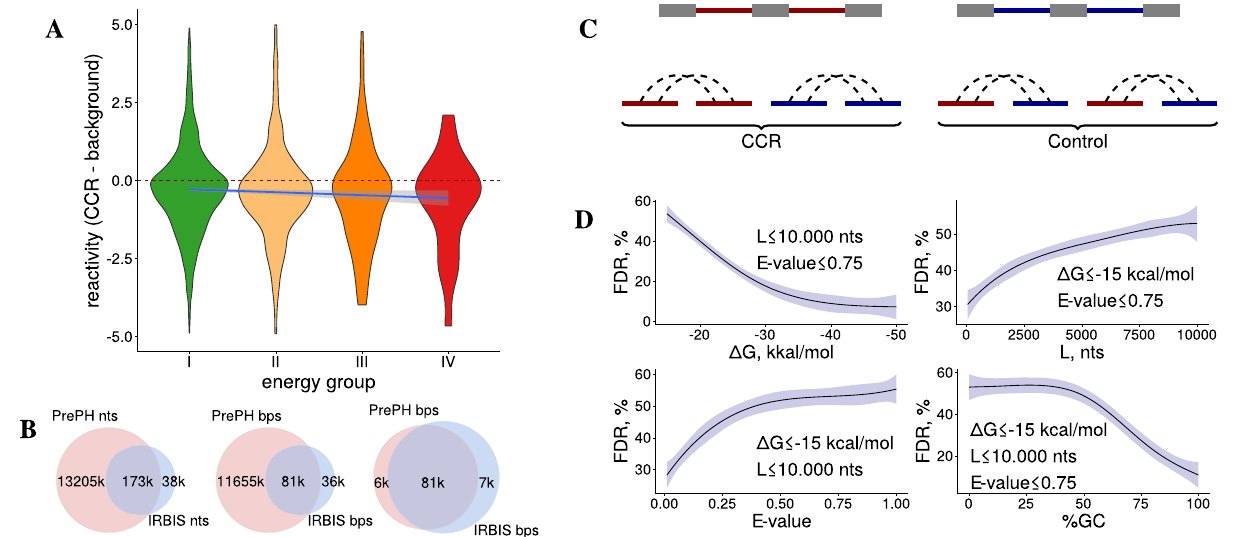
Fig. 2 Validation and false discovery rate (FDR). A The difference between icSHAPE reactivity of nucleotides within CCR and the average reactivity of nearby nucleotides in energy groups I – IV (color code as in Fig. 1C). The linear model Δ reactivity = β 0 + β 1 Δ G group is represented by the slanted line; ^ β ¼ (cid:2) 0 : 03 ± 0 : 01. B Venn diagram for the number of common nucleotides (left), number of common base pairs (middle), and the number of common 1 base pairs among common nucleotides (right) for the predictions of PrePH and IRBIS. C Estimation of the false-positive rate (FDR) by re-wiring, that is, creating a control set that consists of chimeric non-cognate sequences sampled from different genes. D FDR as a function of energy cutoff Δ G (top left), maximum distance between CIR (top right), E value (bottom left), and GC content (bottom right). Solid lines represent the fi tted average over n = 16 randomizations; shaded areas represent 95% con fi dence intervals obtained by the locally estimated scatterplot smoothing (LOESS)